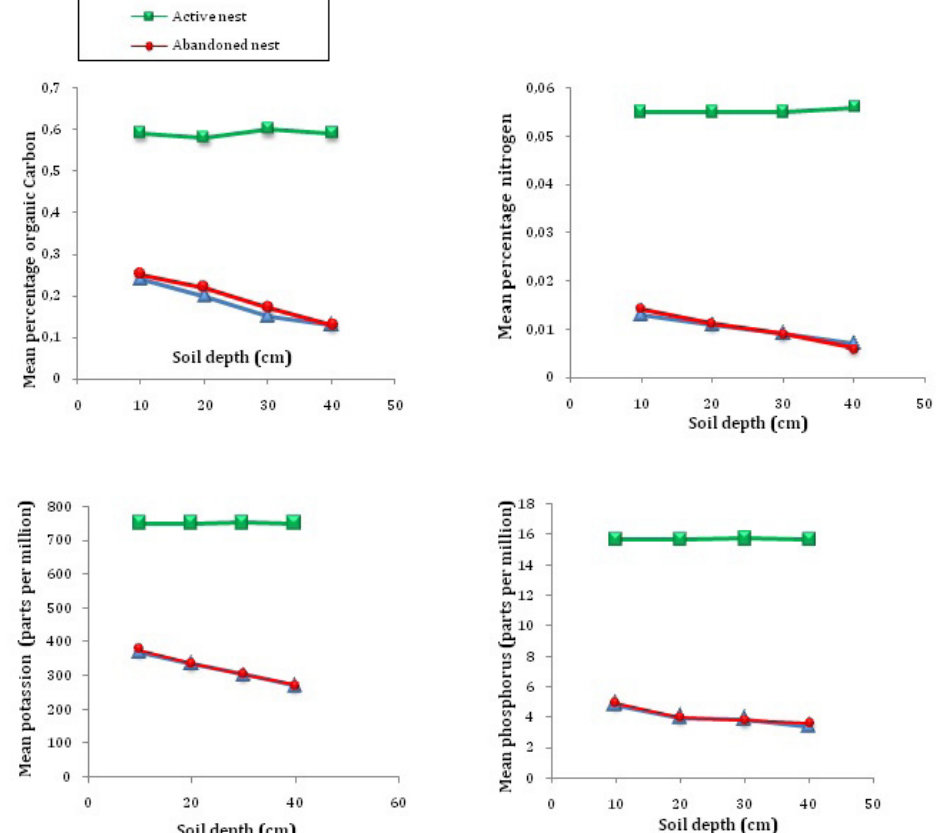
Fig 3 . Nutrient concentrations of soil at four depths in active (n = 18) and abandoned (n = 7) Messor cf. intermedius mounds and control areas (n =